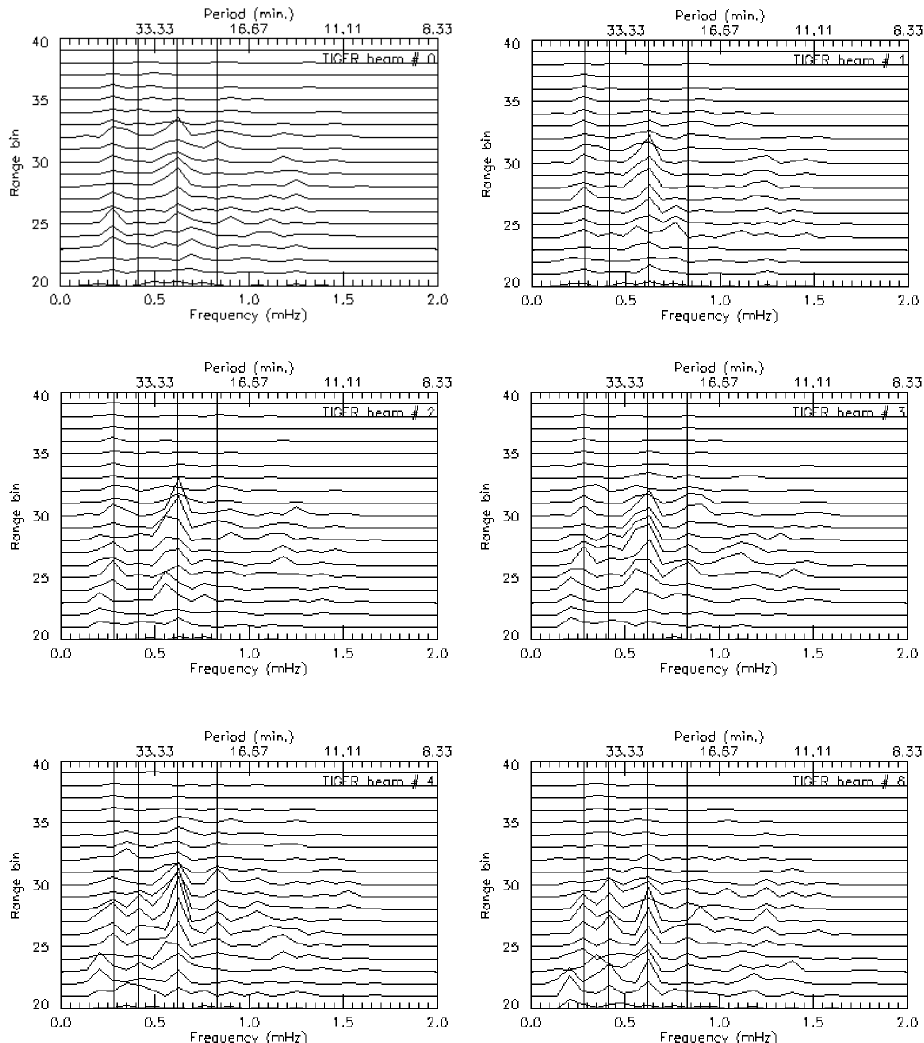
Fig. 5. Stack plot of power spectra calculated for range gates 20 to 40 along all beams, except beams 5, 7, 9 and 15. The scale for spectral power is 2.5 × 10 4 count 2 mHz − 1 per range bin. The solid lines show the power levels at periods of 60, 40, 26 and 20min from beam 4. They are well above the background noise level along most of these